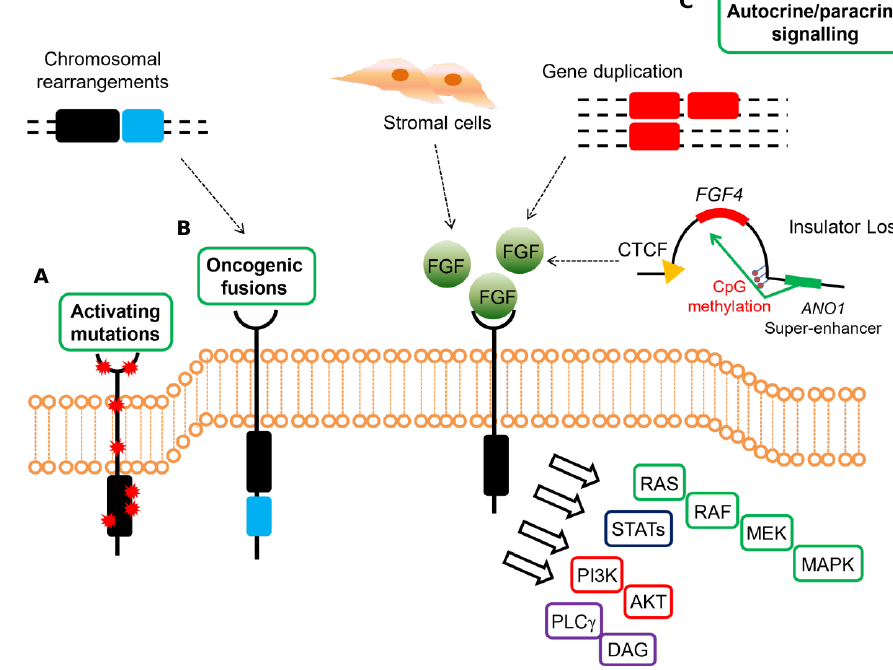
Figure 2. Mechanisms of oncogenic FGFR signaling in gastrointestinal stromal tumors (GISTs). FGFR signaling contributes to oncogenesis through several ligand-dependent and -independent mechanisms in GISTs, signaling through RAS / MAPK, PI3K / AKT, signal transducers and activator of transcription (STATs), phospholipase C γ (PLC γ ). ( A ) Activating mutations resulting in increased kinase activity in absence of ligand are present in quadruple WT GISTs. ( B ) Chromosomal